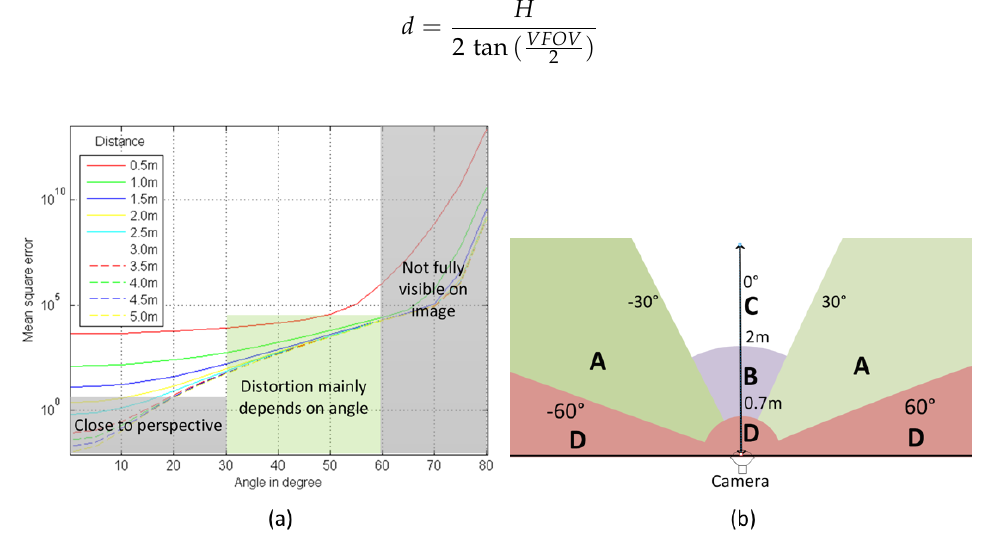
versus the relative position of a person to the camera; ( b ) regions on the fisheye Figure 4. ( a ) MSE p R camera’s